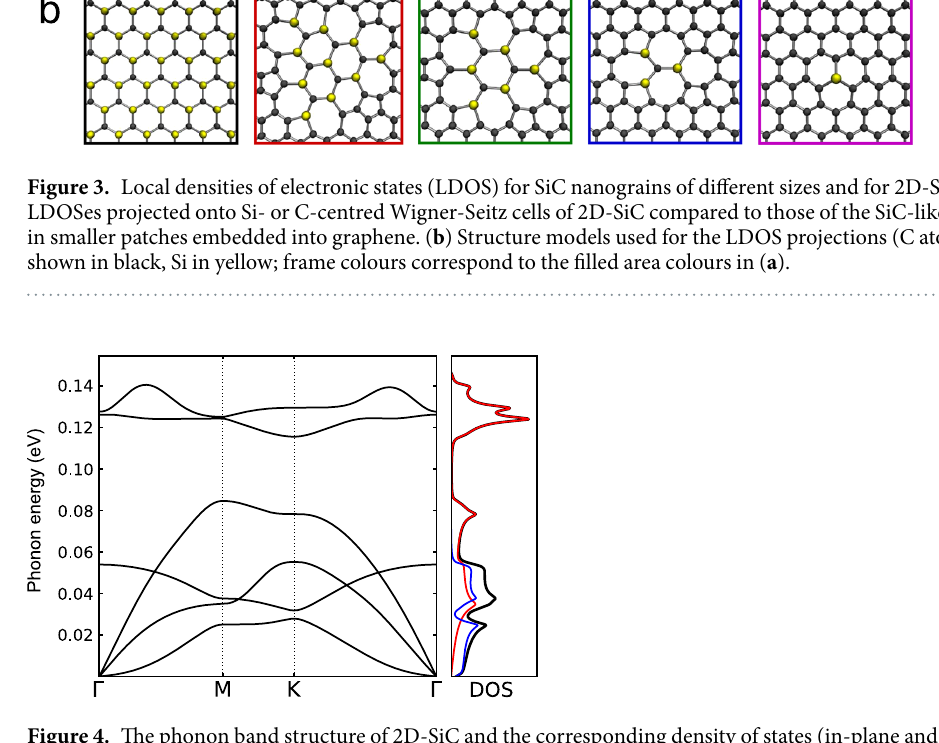
by uniaxially straining the optimal 2D-SiC unit cell and finding the minimum of the resulting total energy curve, resulting in 98.3 GPa.